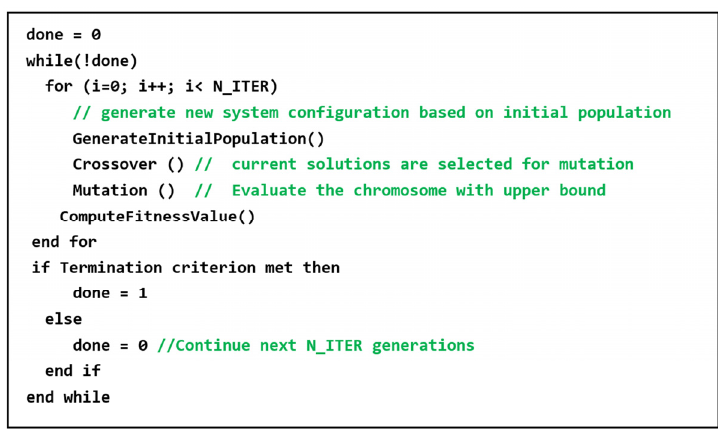
Figure 6. Genetic Algorithm (GA) formulation for hybrid photonic NoC synthesis.